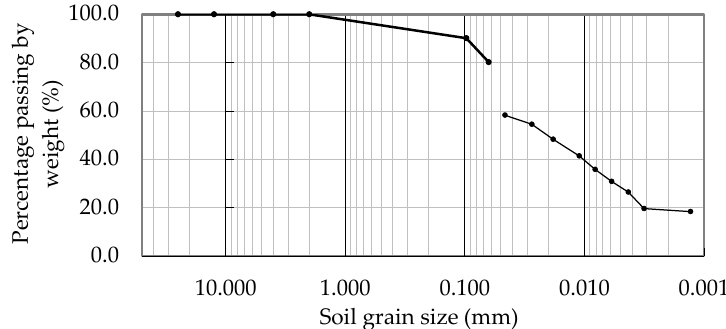
Figure 3. Granulometry test result for a landslide sample.